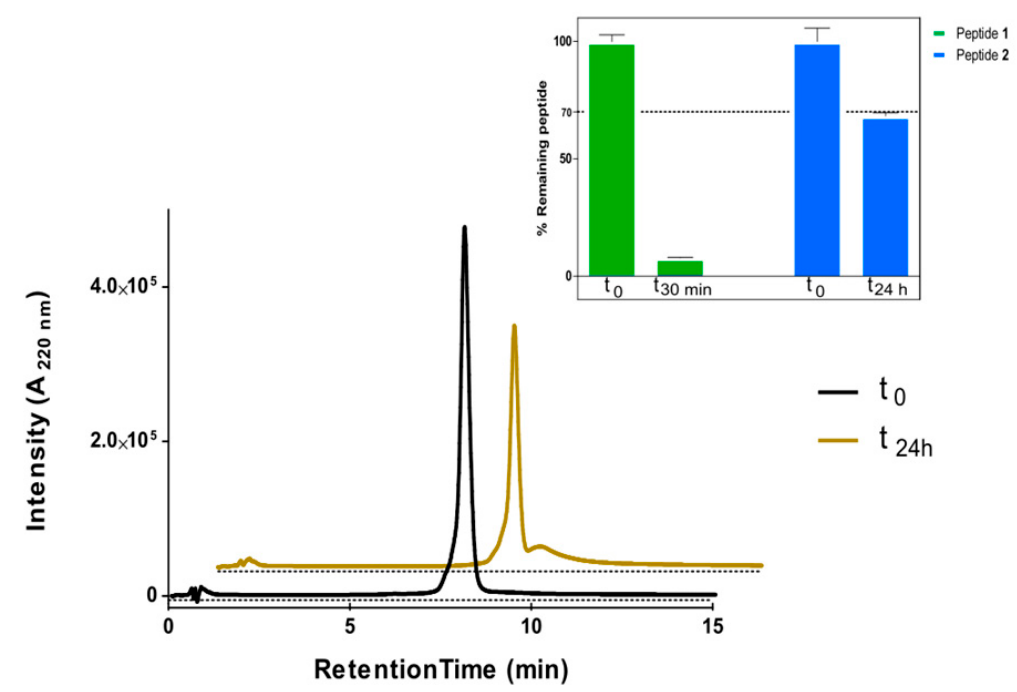
Figure 4. HPLC analysis of cyclic cell-penetrating peptides (CPP)-containing peptide 2 upon incubation with trypsin after 24 h. Inset: comparison of linear ( 1 ) and cyclic ( 2 ) peptide survival. Area of starting peak remaining at the stated time points is shown. Assays were done in duplicate. GraphPad prism was used to fit data.